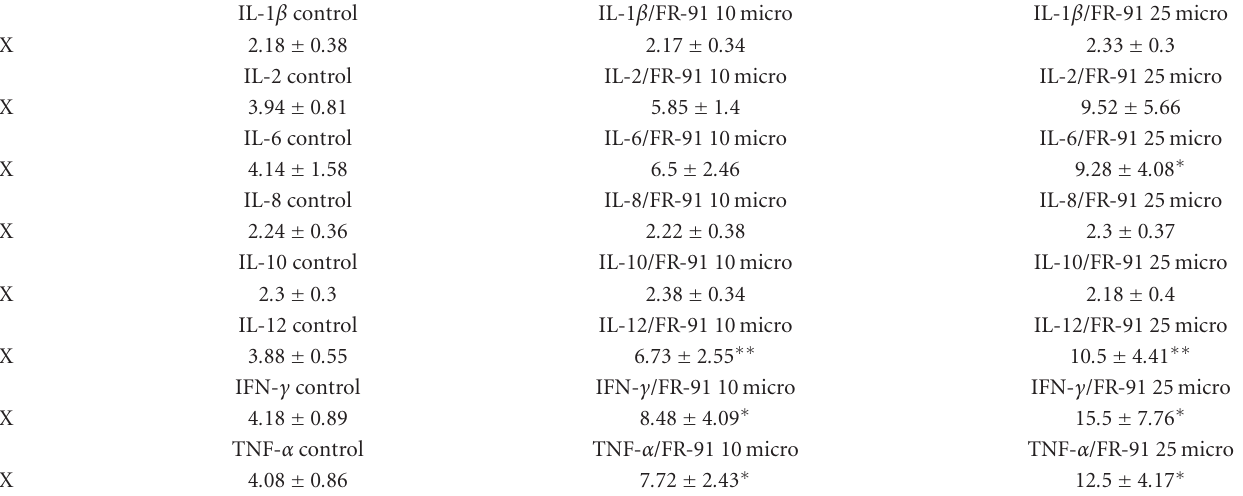
Table 3: E ff ect of FR-91 on production of cytokines by peripheral blood mononuclear cells from healthy subjects. IL-1 β